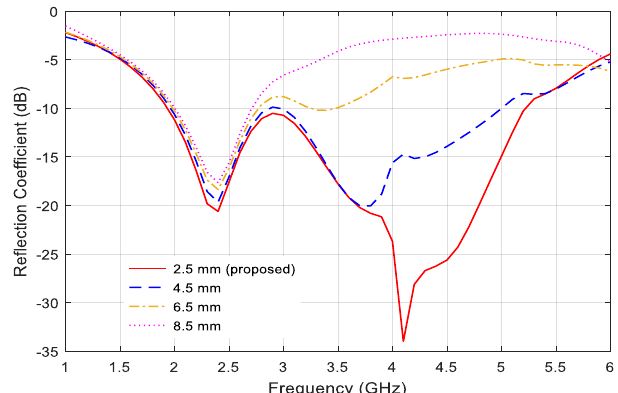
Figure 3. Return loss variation versus frequency for different values of w 6.